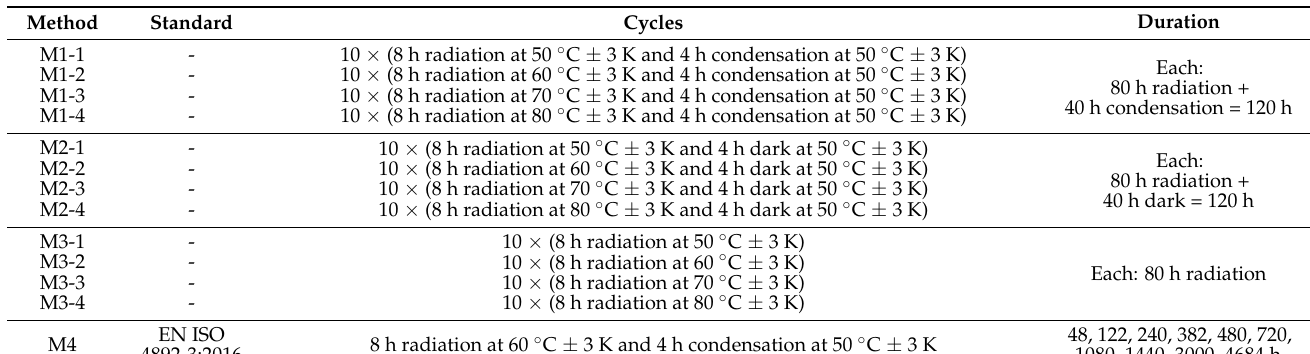
Table 2. Artificial weathering